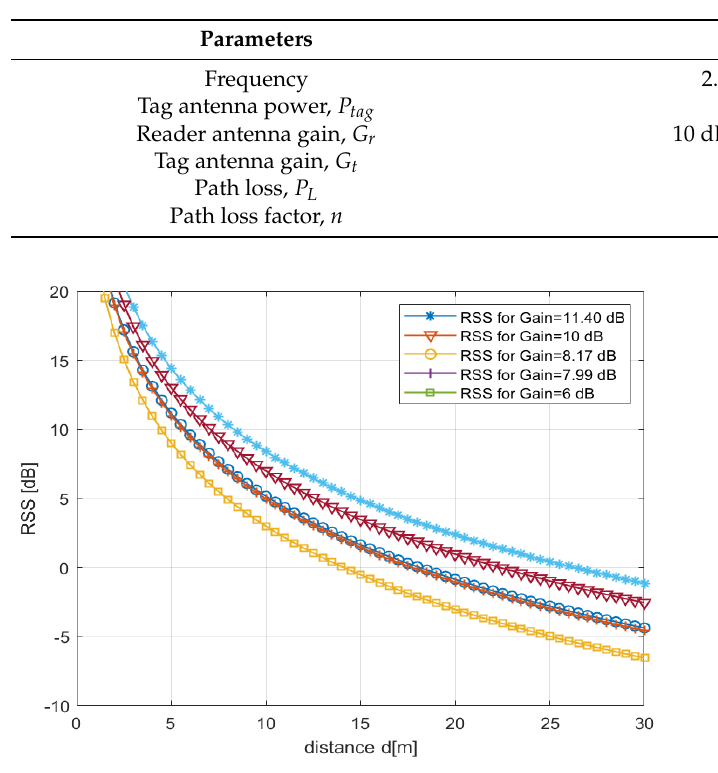
Figure 14. RSS over the distance based on the antenna gains.